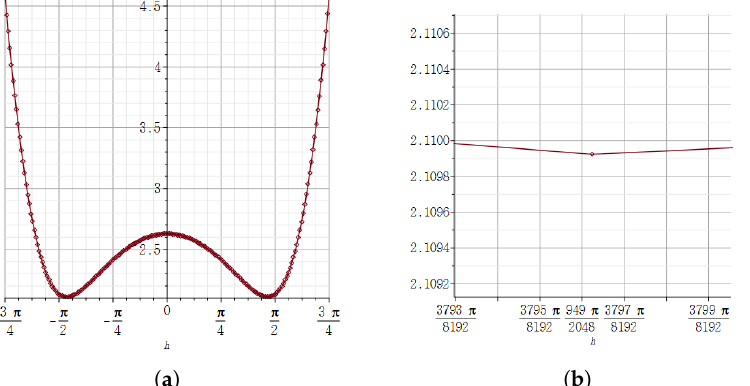
Figure 8. ( a ) The result of expressing the value of the relative error of the quaternion ( j , k ) -step derivative of cos z at z 0 on the vertical axis according to the size of the horizontal axis h using the Maple plot. ( b ) In the graph of ( a ), the result of zooming in about h near π derivative of cos z has a relative error approximated to zero for h near ± π